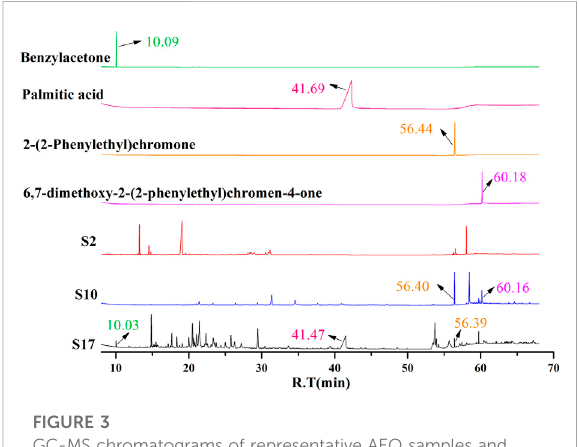
FIGURE 3 GC-MS chromatograms of representative AEO samples and comparison with four characteristic component standards.